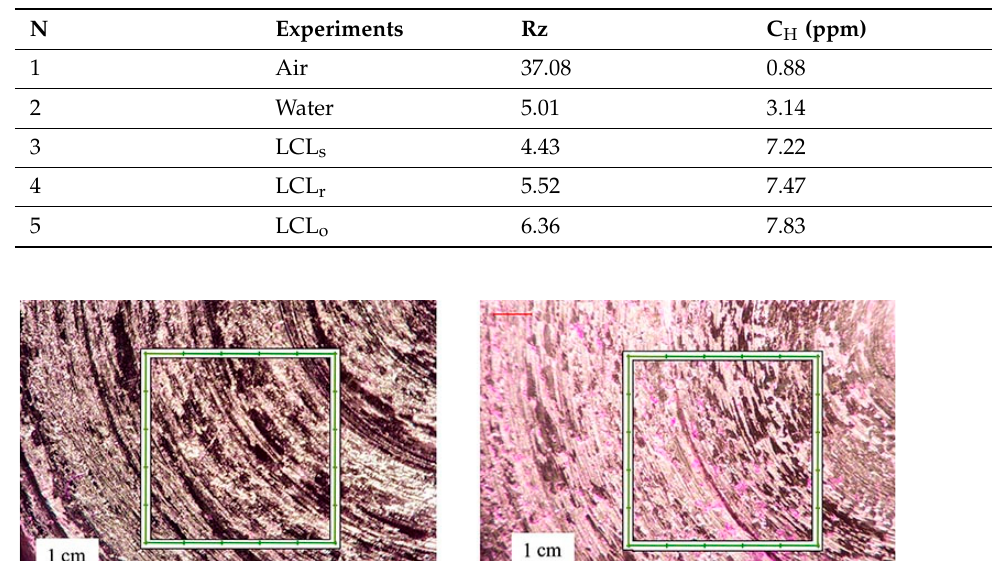
Figure 5. Dependence of the tool wear on the duration of the turning of 38KhN3 М FA steel: (1) dry,